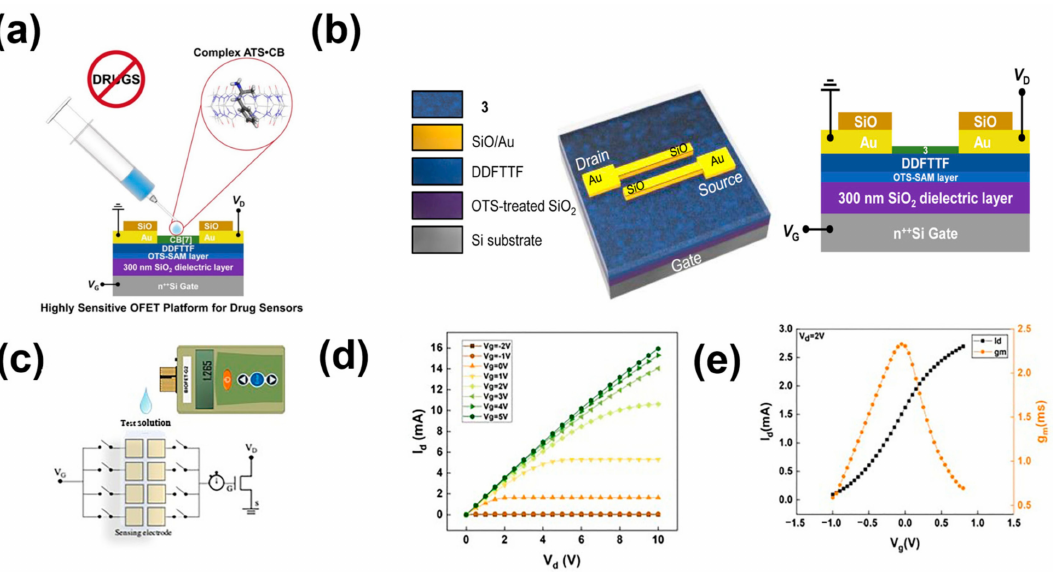
Figure 7. ( a ) Sensor mechanism diagram. ( b ) Sensor diagram based on OFET principle. ( c ) Based on the principle of OFET schematics. ( d ) Diagram of current output value under different